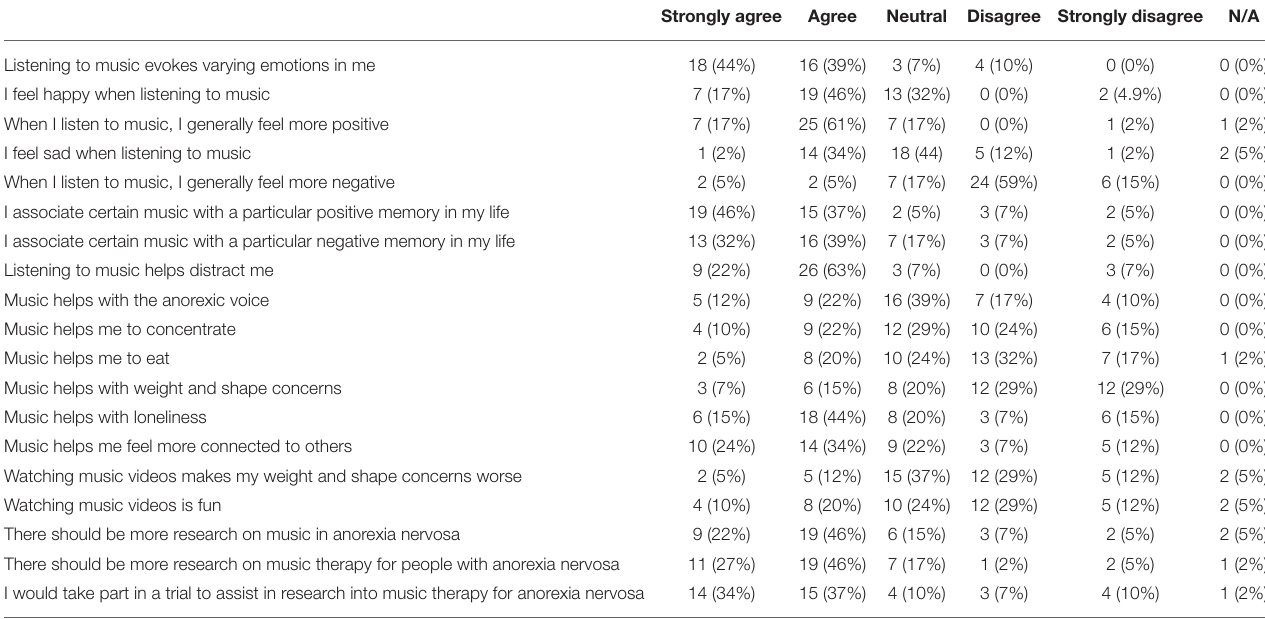
TABLE 3 | Questions and answers regarding patients’ perspective of music and music